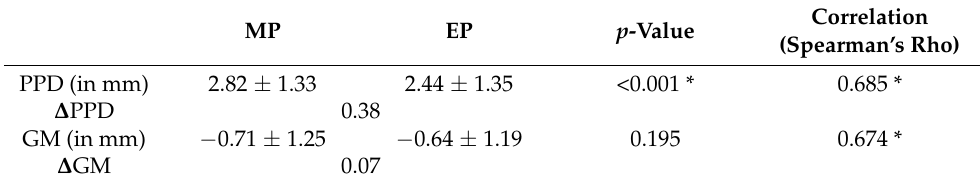
Table 1. Probing pocket depths (PPD) and gingival margins (GM) ( ± standard deviations ) measured either with manual probe (MP) or electronic probe (EP), Spearman’s correlation coefficient. Correlation MP EP p -Value (Spearman’s Rho) PPD (in mm) 2.82 ± 1.33 2.44 ± 1.35 <0.001 * 0.685 * ∆ PPD